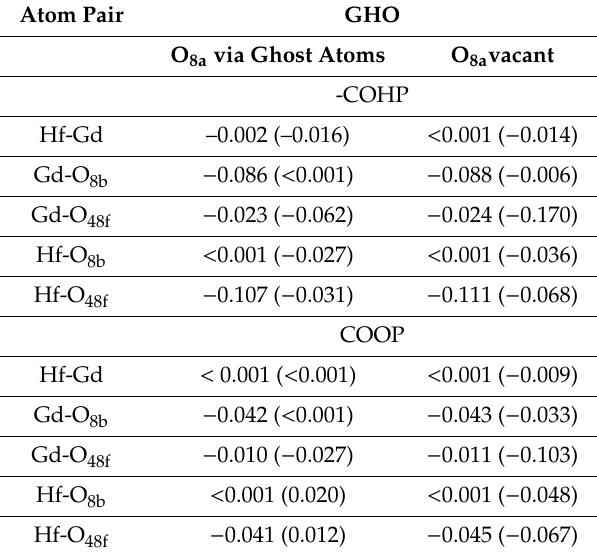
Table 2. COHP and COOP values for the OP-GHO Hf-Gd and metal-O 48f, 8b (metal = Hf, Gd) interactions. Values in parentheses are for the antisite. The -COHP, COOP < 0 are indicative of destabilizing